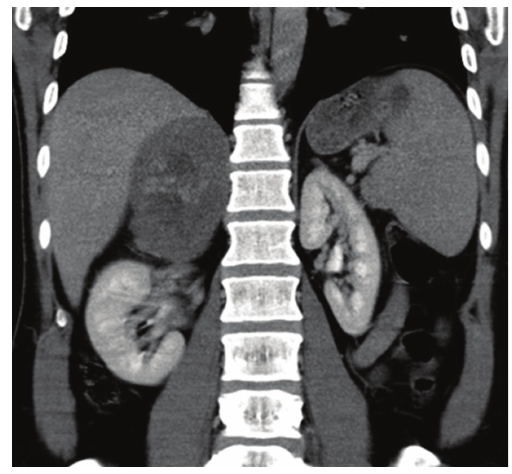
Figure 4: Coronal reformatted image at nephrographic phase shows the enhancing central